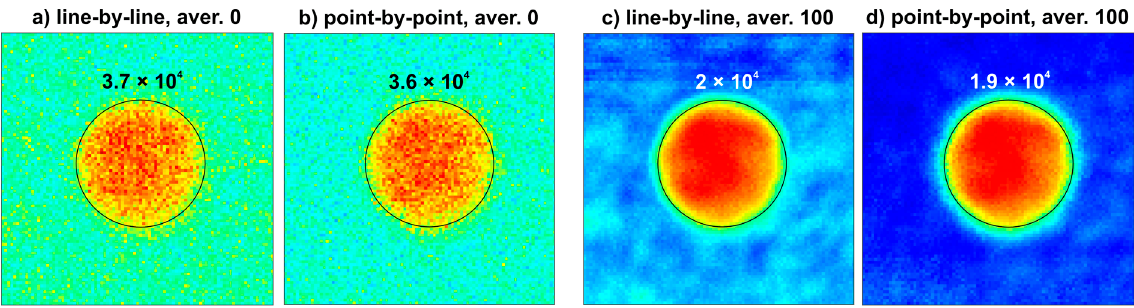
Figure 12. C-scans of the 19-mm-diameter defect area measured with various schemes. All images have the same resolution.